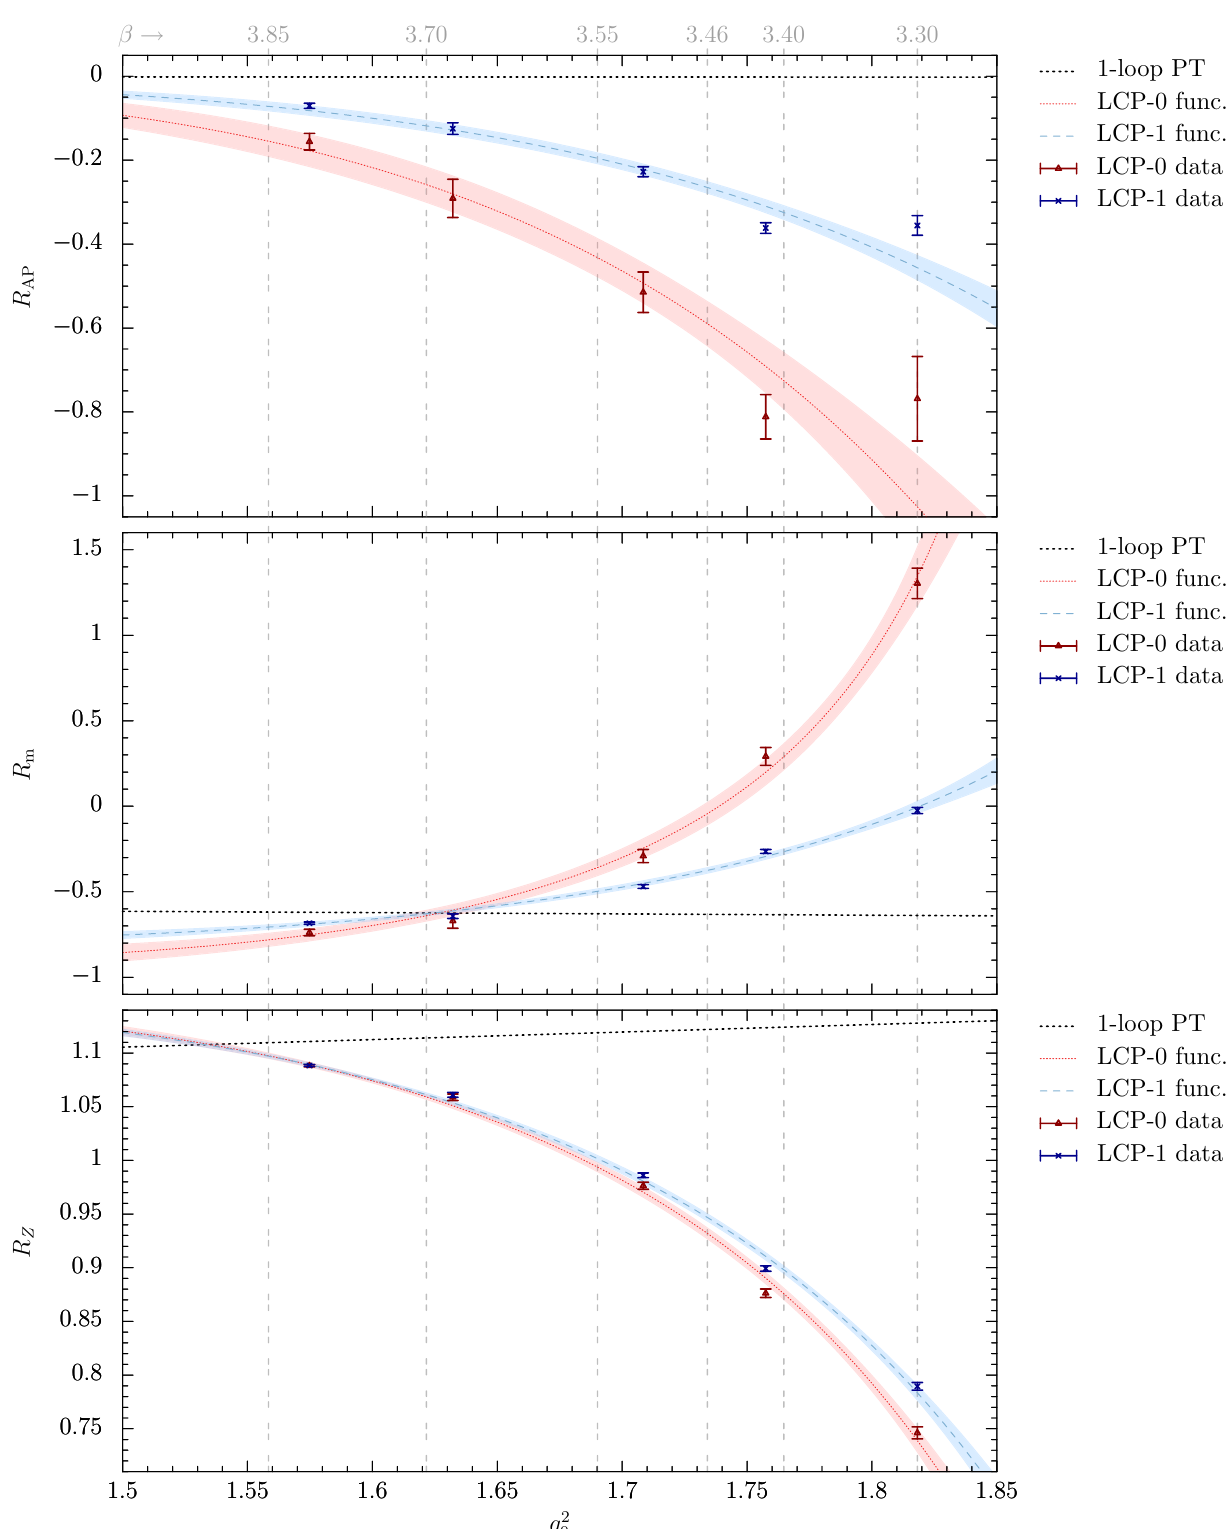
Fig. 7 Estimators R ( 0 ) for LCP-0 and LCP-1 and their interpolating functions according to Eq. (5.1). Vertical lines indicate CLS g 2 X straight dotted lines represent the one-loop perturbative